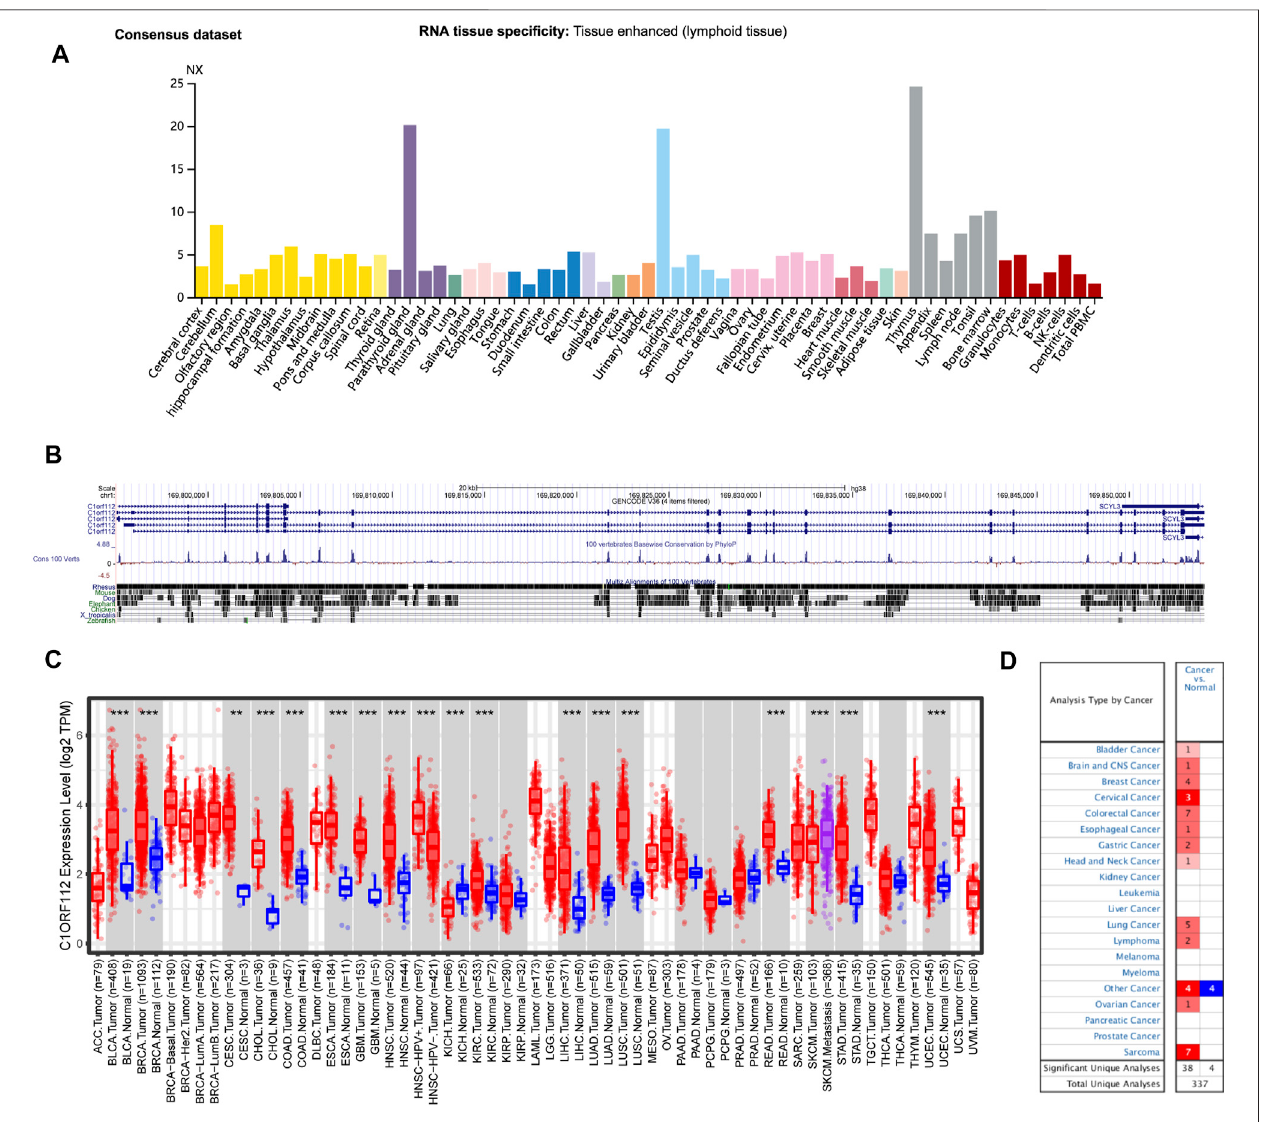
FIGURE 1 | C1ORF112 expression status in different tumors and normal tissues and C1ORF112 gene conservation among vertebrates. (A) Consensus C1ORF112 tissue expression based on datasets of HPA (Human Protein Atlas), GTEx, and FANTOM5 (function annotation of the mammalian genome). (B) C1ORF112 gene conservation analysis among vertebrates was visualized using the UCSC genome browser. (C) The expression status of C1ORF112 in different tumor types was visualized by TIMER2. * p < 0.05; ** p < 0.01; *** p < 0.001. (D) Oncomine pooling analysis of C1ORF112 expression in various tumor types.